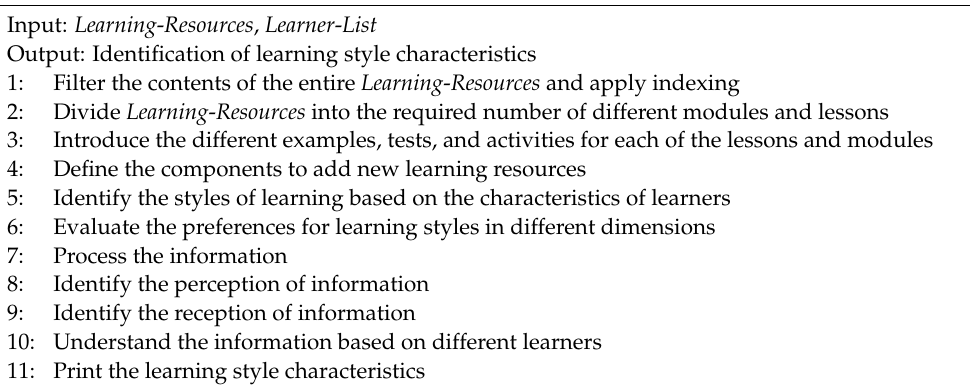
Algorithm 1 General Structure of the Proposed Intelligent Hybrid